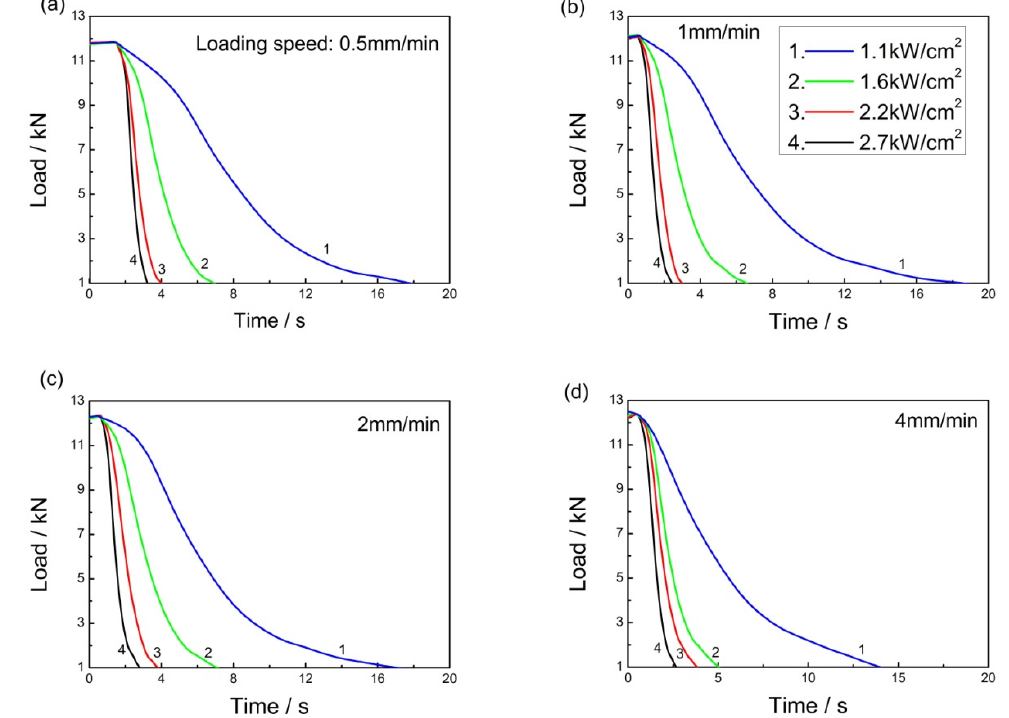
Figure 2. Failure behavior of Al-7075 specimens for various laser power densities under the fixed preloading speeds. ( a ) 0.5 mm/min; ( b ) 1 mm/min; ( c ) 2 mm/min; ( d ) 4 mm/min.